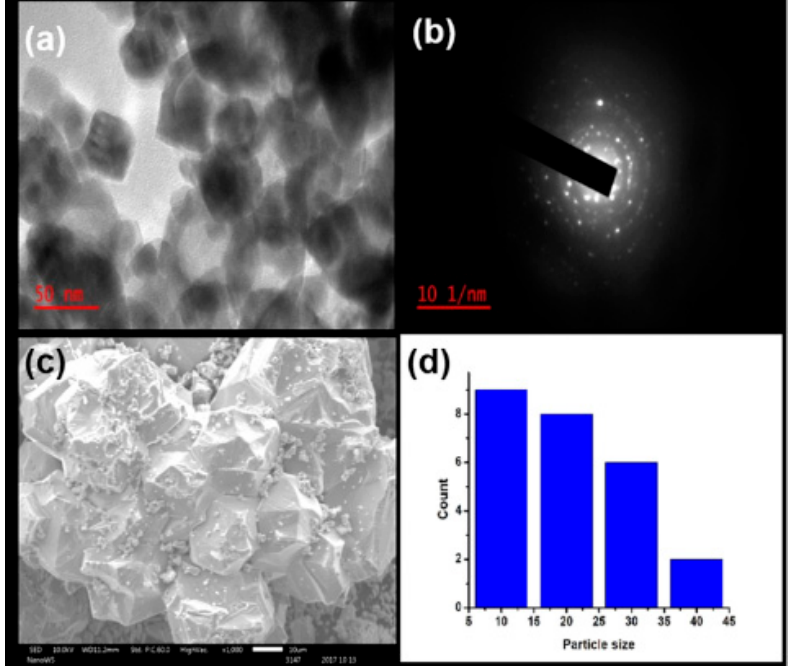
Figure 6. ( a ) TEM image of M. burkeana -mediated ZnO NPs, ( b ) with their SAED, ( c ) SEM and ( d ) particle bar graph size. Adapted from [24].